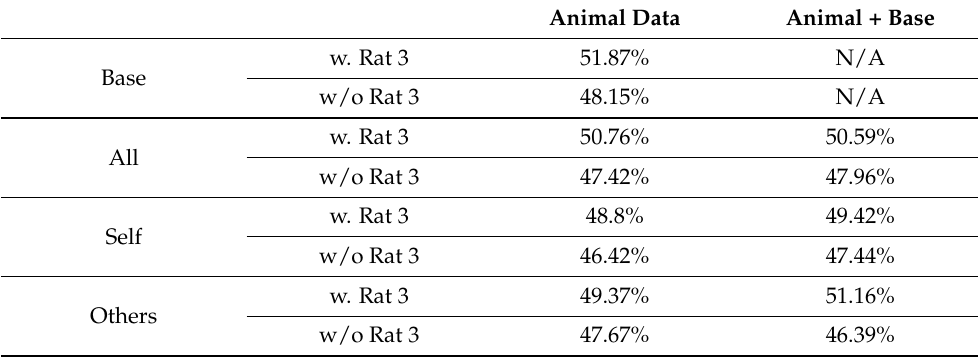
Table 4. Mean sizes of the compressed signals relative to the original data for in vivo tests. Columns for dictionaries using experimental data alone or added to the base dictionary. Rows for base dictionaries, dictionary from data from all the animals (All), dictionaries from data from each individual rat (Self), or dictionaries from data from all animals except the one being tested (Others). Data shown including and excluding the anomalous rat labeled “Rat